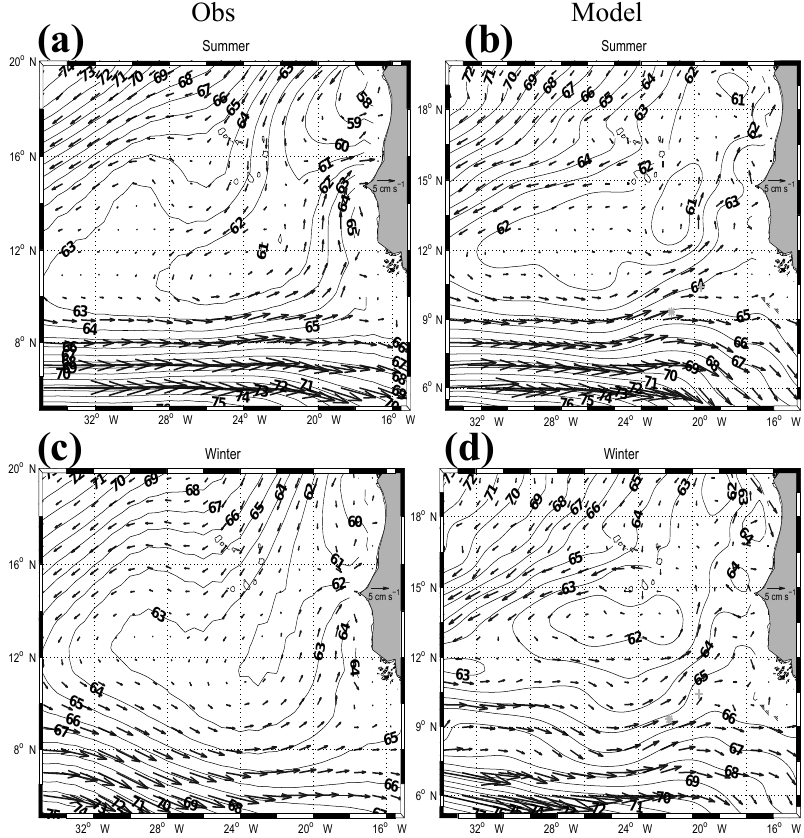
Figure 4. Summer (June–September, a, b ) and winter (December–February, c, d ) mean dynamic height at 50m relative to 500m (m 2 s − 2 ). The contour interval is 1m 2 s − 2 . The associated geostrophic circulation is also shown (vectors). Panels (a, c) are for observations (TROP025). To ease comparison with the observations, 3m 2 s − 2 was uniformly subtracted from the model fields.